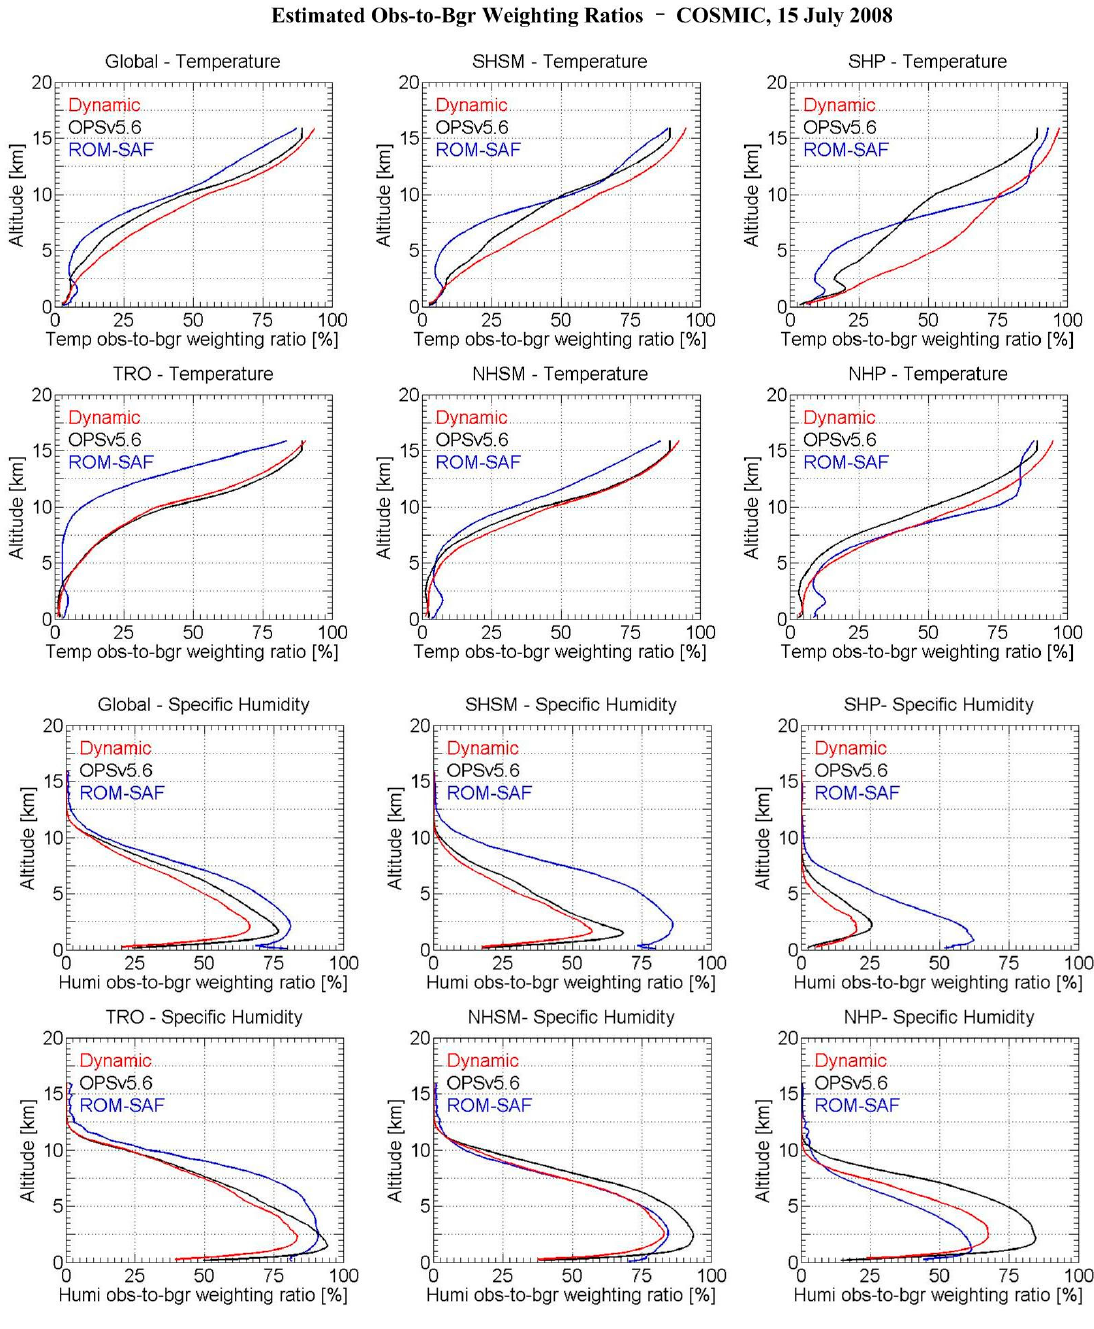
Figure 10. Observation-to-background weighting ratio profiles for temperature (six panels in upper two rows) and specific humidity (six panels in lower two rows), for the COSMIC data ensemble of 15 July 2008, are shown for the global ensemble (Global) and the five latitudinal bands TRO, SHSM, NHSM, SHP, and NHP (identified in the panel titles). The results for the dynamic, OPSv5.6 and ROM-SAF approaches are all shown.